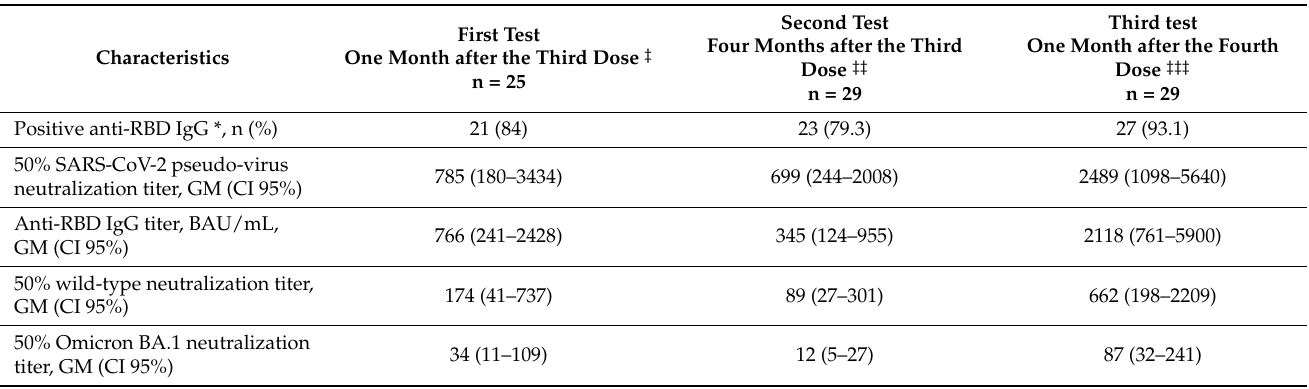
Table 4. The Humoral immune response of 29 patients after being vaccinated with a fourth dose of the BNT162b2 mRNA vaccine.